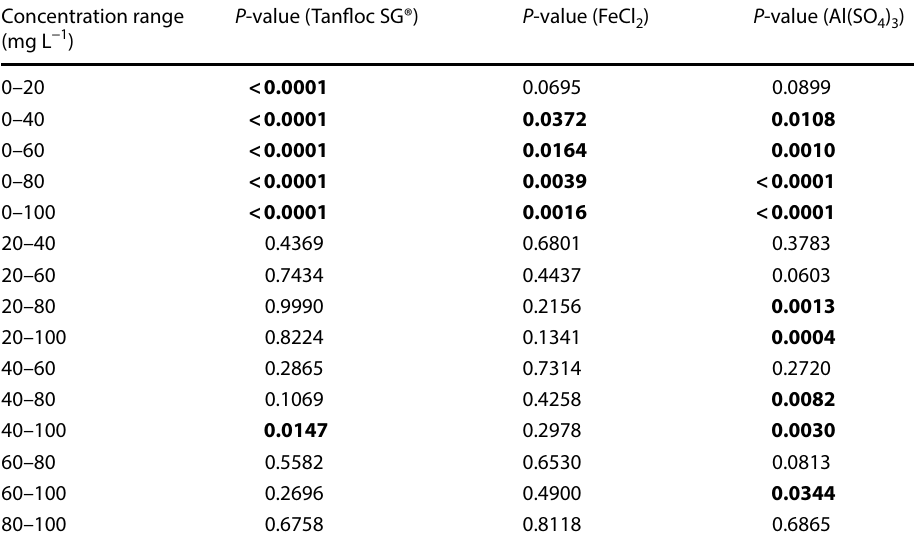
Table 2 t-test assuming different variances for the Tanfloc SG®, FeCl coagulant (α =